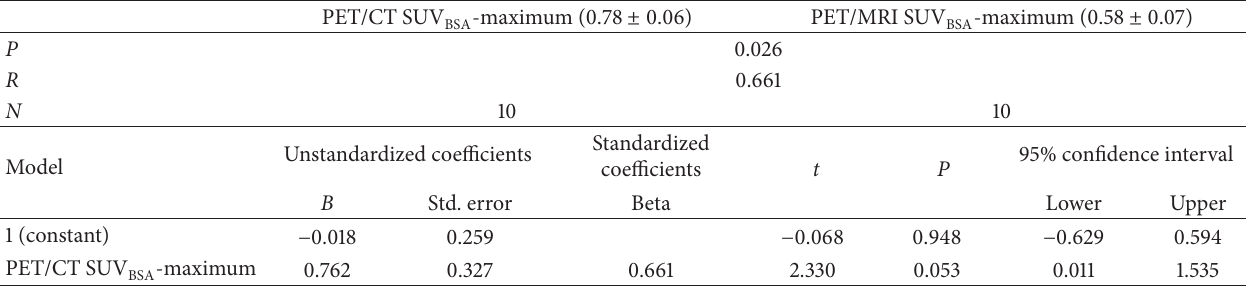
-maximum and PET/MRI SUV BSA